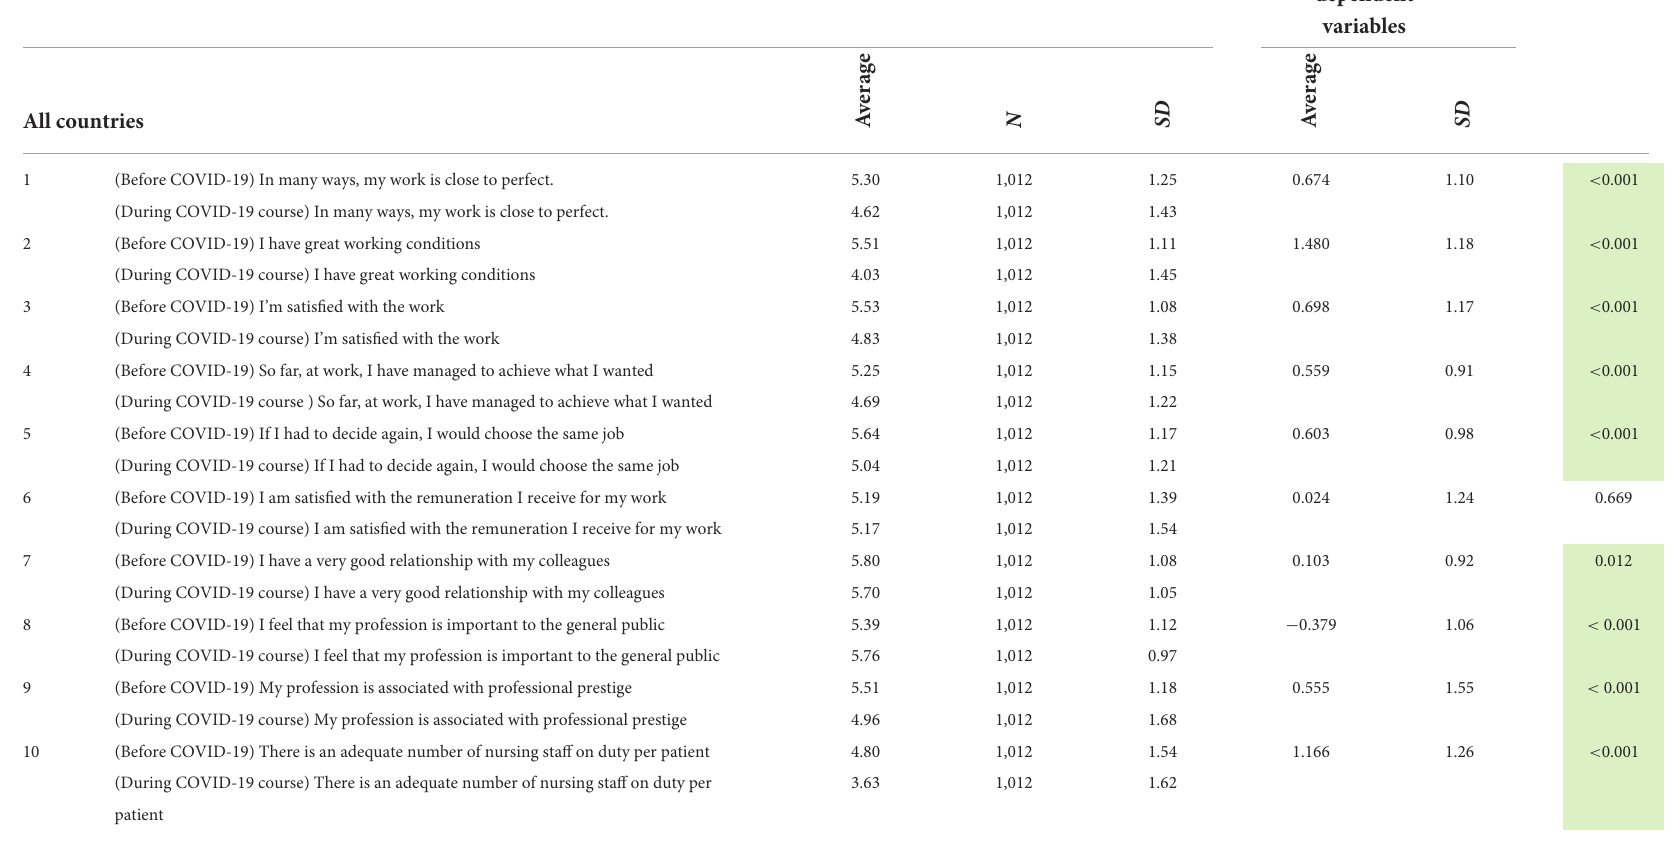
TABLE 2 Impact of the pandemic on professional job satisfaction among the nursing staff. Results for dependent variables Differences in